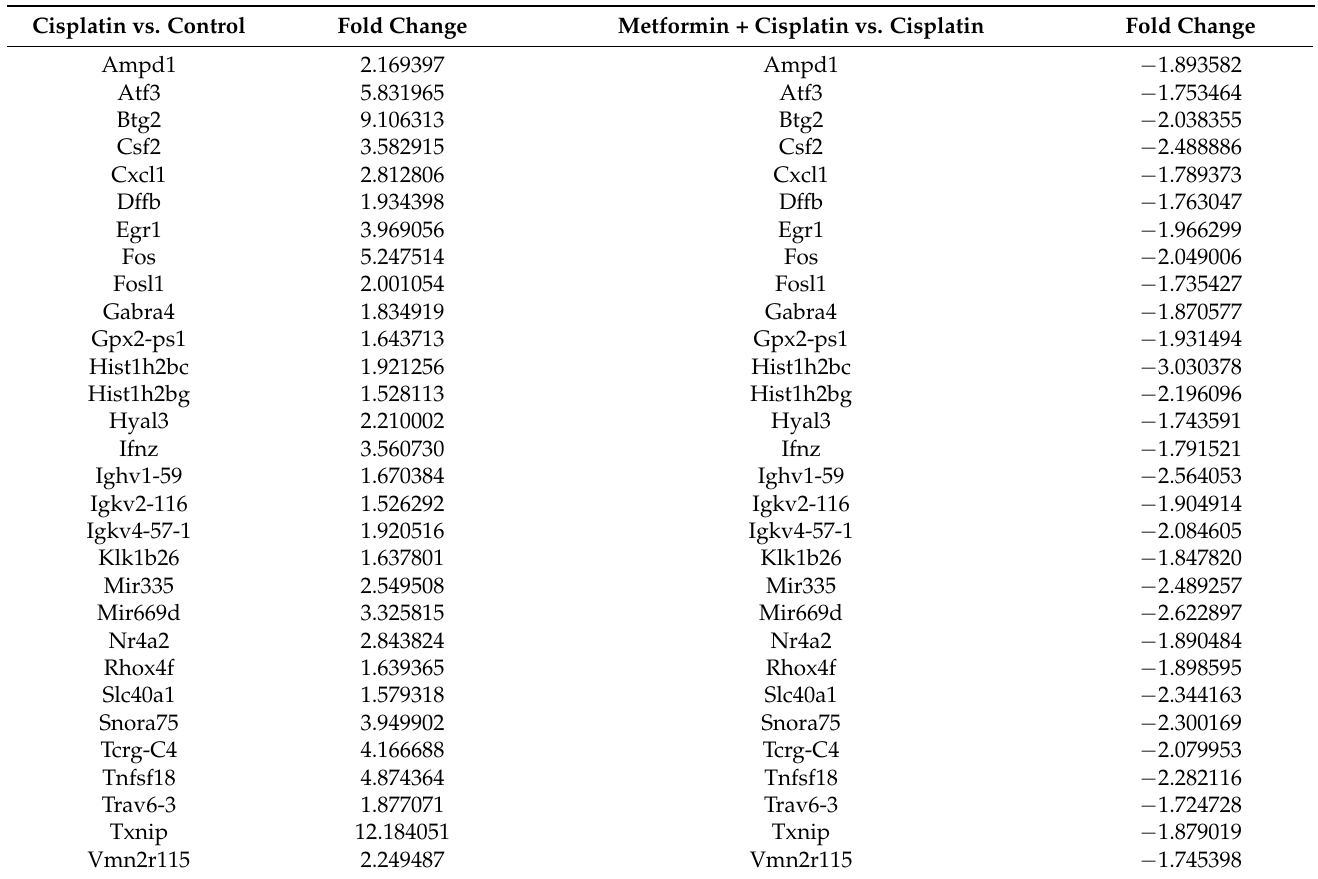
Table 7. List of involved genes which are expressed oppositely in 48 h cisplatin group and 48 h metformin pretreated